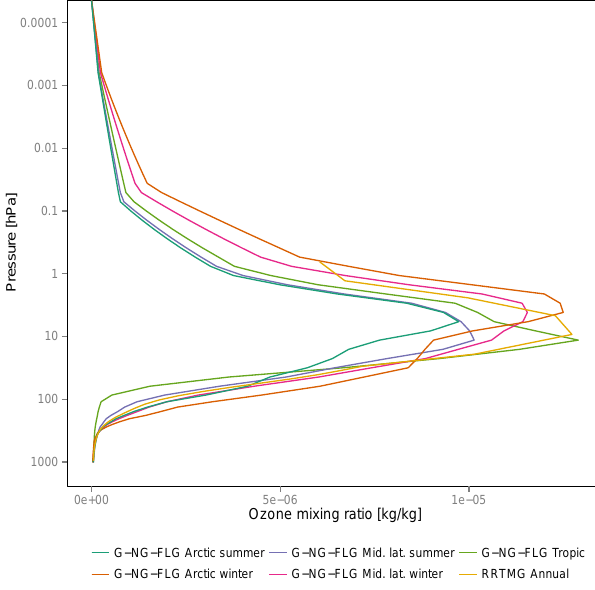
Figure 1. Ozone profile data sets available in the G-NG-FLG and RRTMG